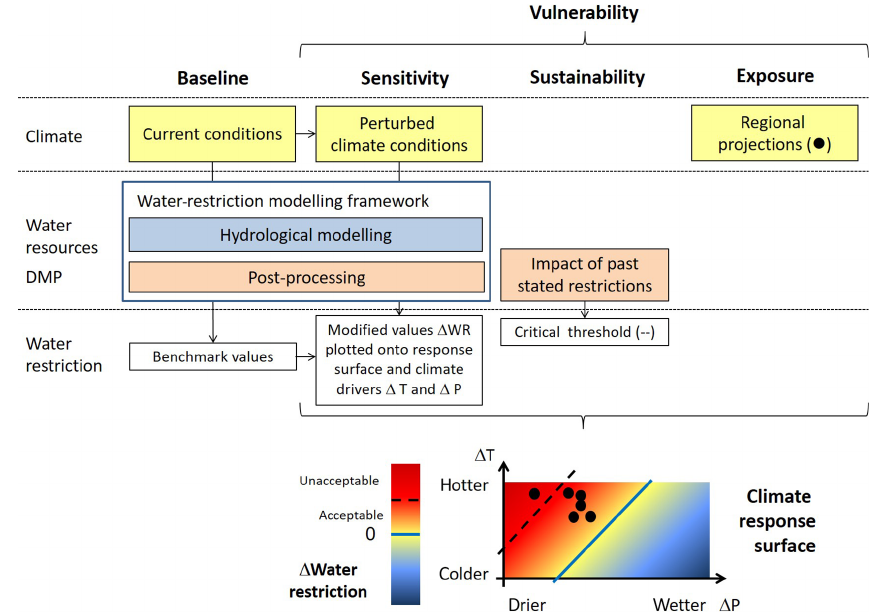
Figure 4. Schematic framework of the developed approach to assess the vulnerability of the DMPs under climate change.